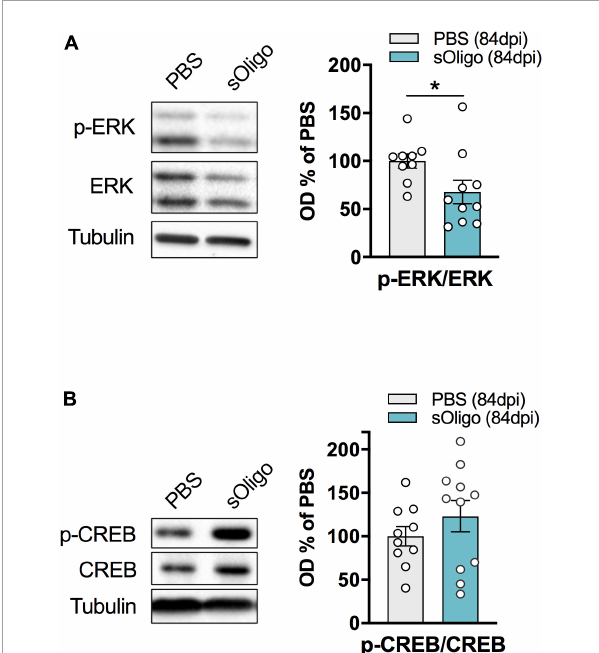
FIGURE3 Effects of in vivo striatal injection of α Syn soluble oligomers in mice on ERK and CREB signaling. (A) Levels of pERK were evaluated by Western blot in striatal homogenates of sOligo- and PBS-injected mice 84 dpi. pERK level was normalized on total ERK expression and reported as OD% of PBS-mice. n = 9–10 mice. (B) Levels of pCREB were evaluated by Western blot in striatal homogenates of sOligo- and PBS-injected mice 84 dpi. pCREB level was normalized on total CREB expression and reported as OD% of PBS-mice. n = 10–11 mice. Data are represented as mean ± SEM. * P < 0.05 (Student’s t -test; data with non-normal distribution were tested with Mann–Whitney